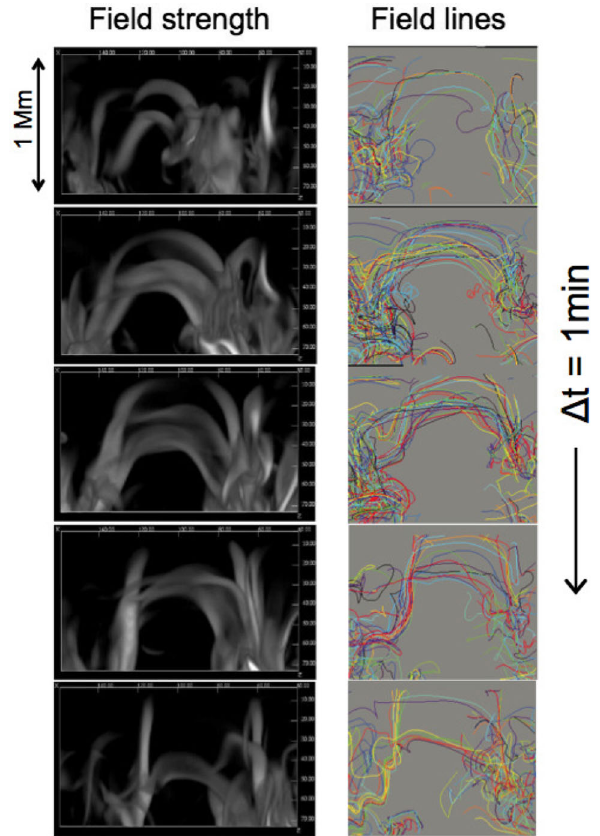
Fig. 38 An example of magnetic loops emerging in the solar atmosphere as observed in 3D magnetocon- vection simulations. The panels on the left show renderings of the magnetic field strength and those on the right display sample field lines. The temporal cadence of the snapshots is 1 min. Image reproduced with permission from Stein and Nordlund (2006), copyright by